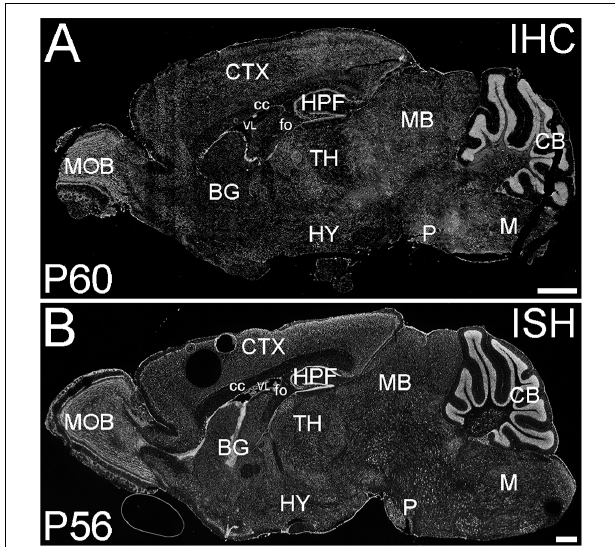
FIGURE 4 | ELOVL4 protein and mRNA distribution in the adult mouse brain. (A) Immunofluorescent labeling for ELOVL4 in the postnatal day 60 mouse brain is widely distributed, but shows cell-specific distribution in different regions of the brain. (B) In situ hybridization (ISH) for Elovl4 mRNA in the mouse brain at P56 shows distribution similar to that of ELOVL4 protein. (Image from: Allen Institute for Brain Science Allen Mouse Brain Atlas for the P56 mouse brain, image number 69059903_134; http://mouse.brain-map. org). CB, cerebellum; BG, basal ganglia; CTX, cerebral cortex; HPF, hippocampal formation; HY, hypothalamus; M, medulla; MB, midbrain; MOB, main olfactory bulb; P, pons; cc, corpus callosum; fo, fornix; VL, lateral ventricle. Scale bars = 1 mm (figure from Sherry et al., 2017). Used with open access under the Creative Commons attribution license CC-BY, version 4.0;